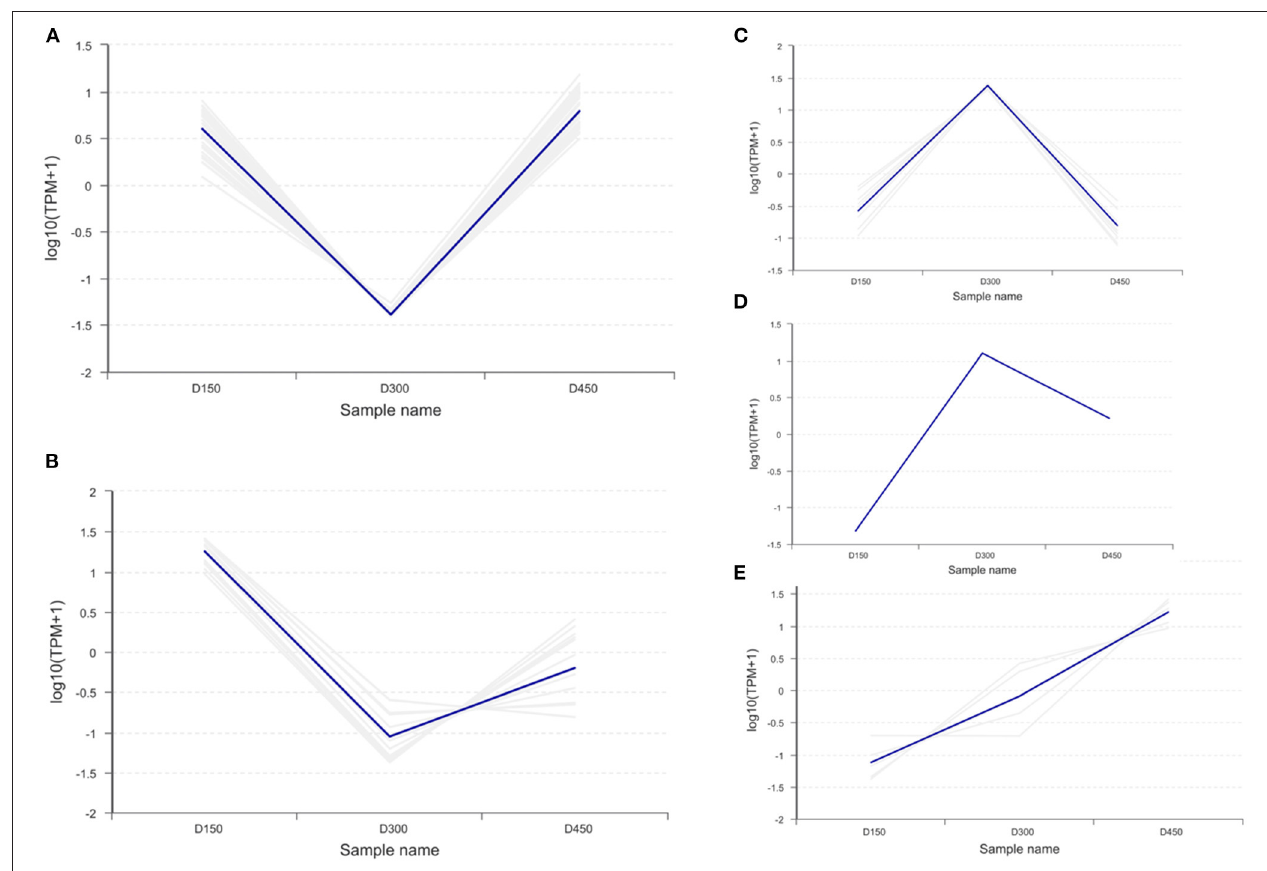
FIGURE 7 | Clustering analysis of the 57 differentially expressed proteins related to fatty acid metabolism in the three different chronological ages (D150, D300, and D450) of breast muscle. (A) Cluster 1 (29 proteins) down-regulated significantly from D150 to D300, then up-regulated sharply from D300 to D450. (B) Cluster 2 (13 proteins) down-regulated from D150 to D300 then up-regulated slowly from D300 to D450. (C) Cluster 3 (9 proteins) up-regulated steadily from D150 to D300 then sharply down-regulated from D300 to D450. (D) Cluster 4 (1 proteins) up-regulated sharply from D150 to D300, then slowly down-regulated from D300 to D450. (E) Cluster 5 (5 proteins) up-regulated consistently from D150 to